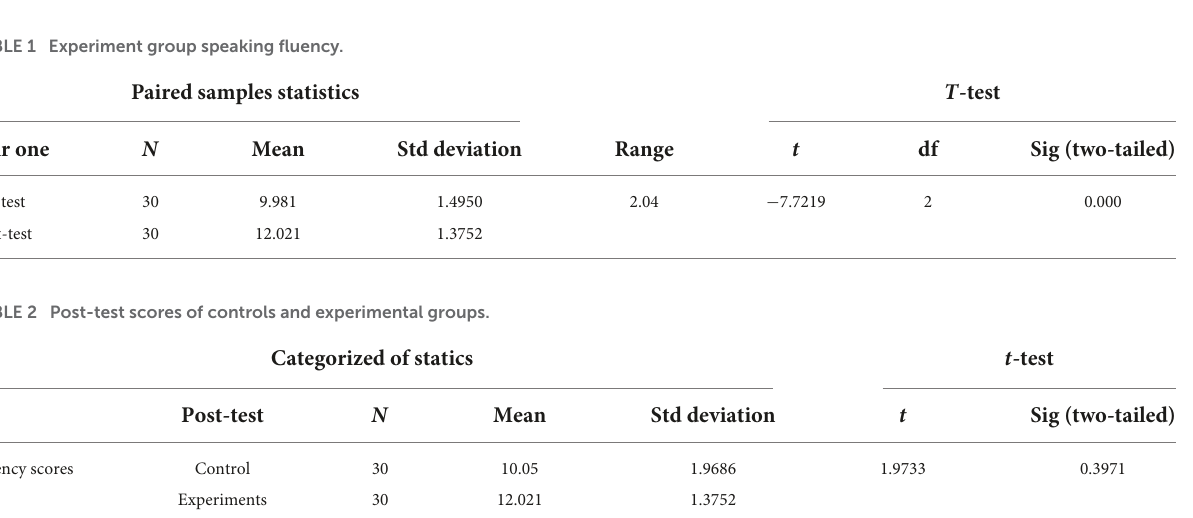
TABLE 1 Experiment group speaking fluency.